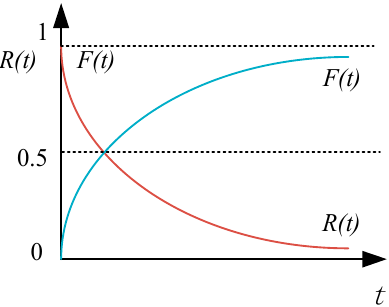
Figure 3. System reliability function curve changing with system time.